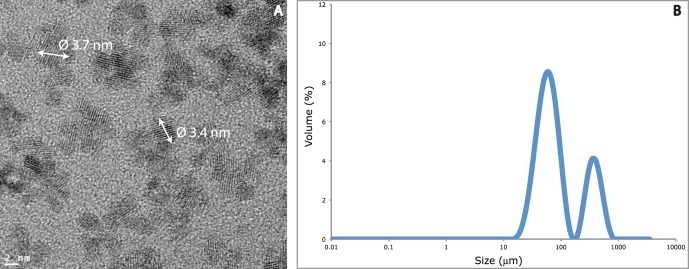
Physico-chemical characterization of the CeO2 NPs.TEM picture of the CeO2 in deionized water (A) and distribution of the hydrodynamic diameters within daphnia medium (B).